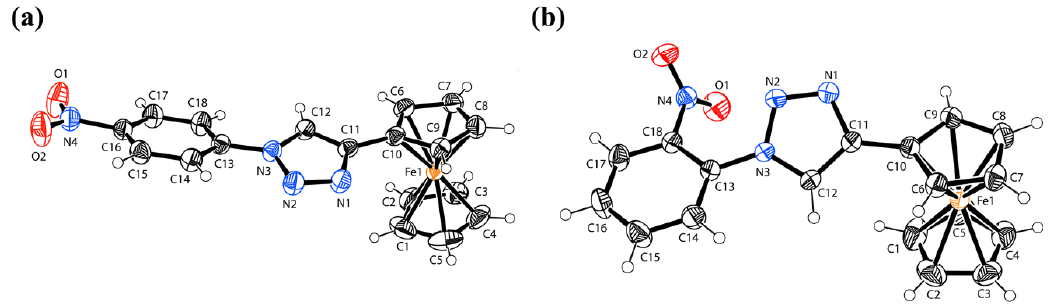
Figure 1. The molecular structure of compounds ( a ) X1 and ( b ) X5 with atom labeling. Displacement ellipsoids are drawn at the 40% probability level.